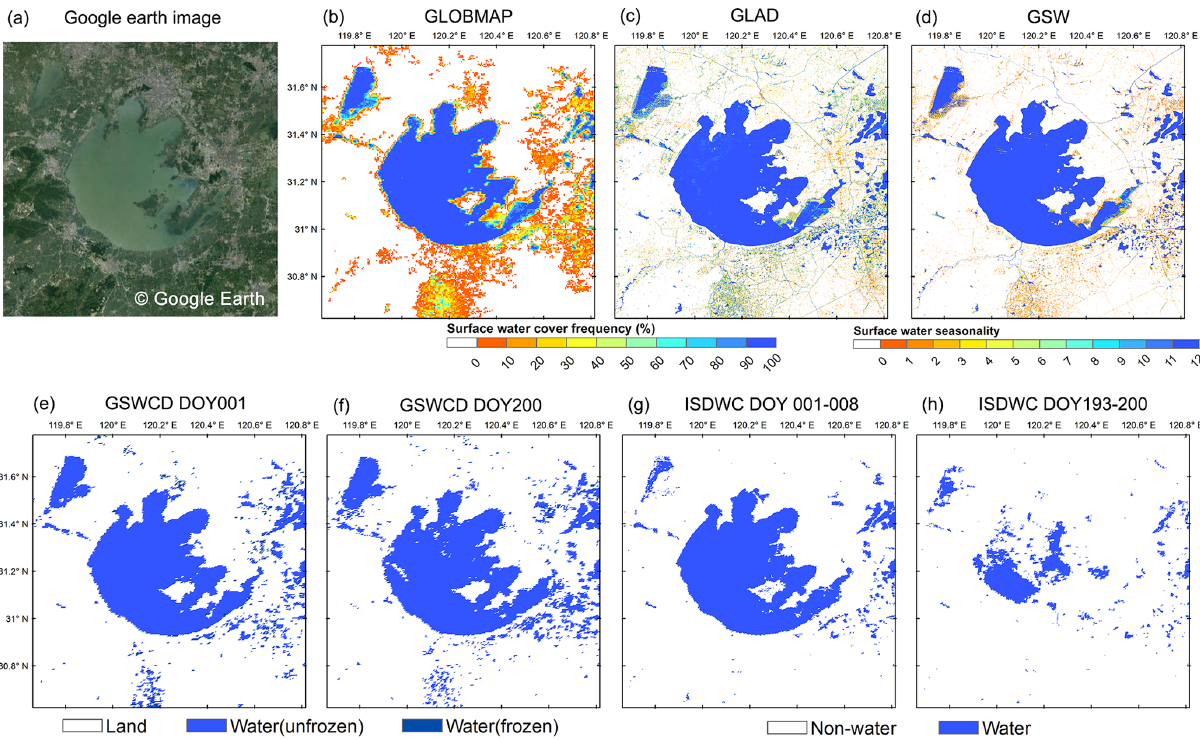
Figure 3. Comparison of surface water map of GLOBMAP SWF, GLAD, GSW, GSWCD and ISDWC in frequently cloud-covered areas around Taihu Lake in eastern China (30.62–31.78 ◦ N, 119.66–120.82 ◦ E) in 2015. (a) Google Earth high-resolution image (from Google Earth), (b) GLOBMAP surface water cover frequency, (c) GLAD annual water percent and (d) GSW seasonality (source: EC JRC/Google). Surface water extent of GSWCD in (e) DOY001 and (f) DOY200 in 2015 and surface water extent of ISDWC in (g) DOY001–008 and (h) DOY193–200 in